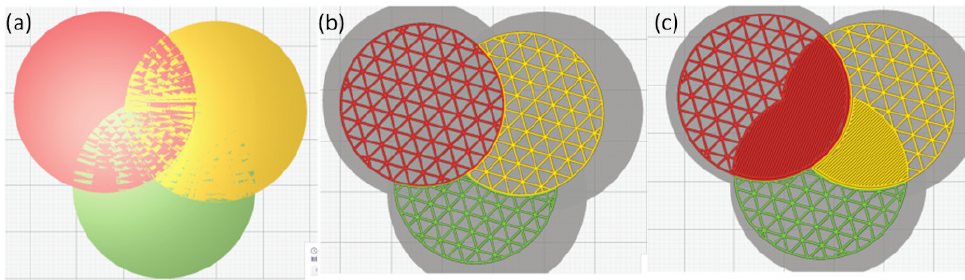
Figure 2. ( a ) A model having three overlapping cylinders (top view). During slicing, Cura either ( b ) lets one infill take over the overlapping region or ( c ) makes the region